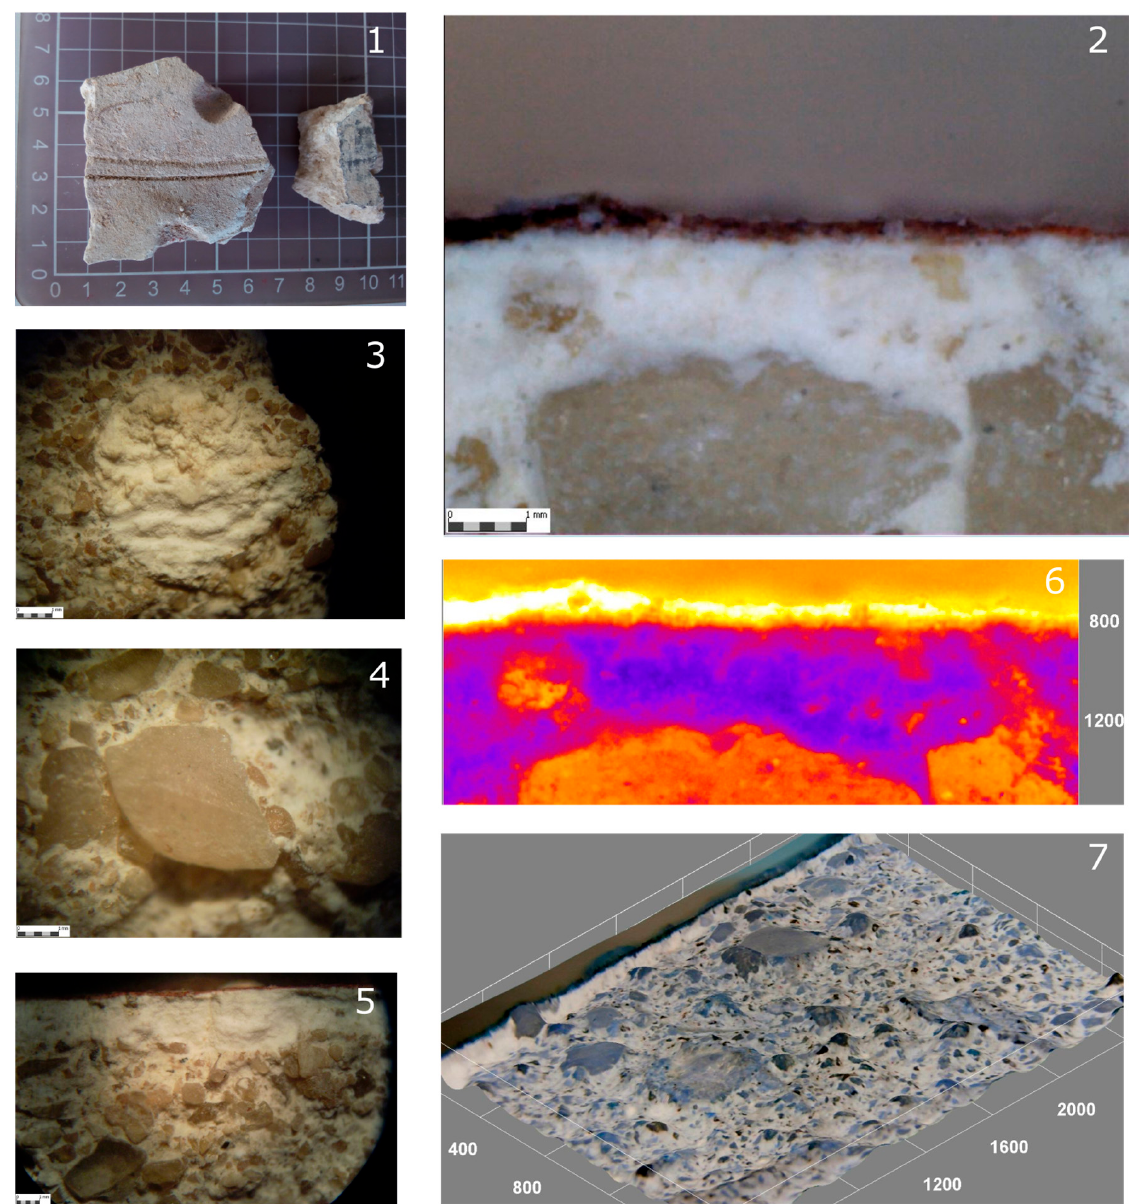
Figure 4. Macroscopic analysis of sample NO1 (1 mm scale): (1) Photo of sample before treatment, (2) cross-section without treatment (×50 mag.), (3) lumps of lime, (4) quartz grains, (5) cross section with reflected light, (6) thermal LUT analysis of cross section using ImageJ software showing the outside layer (yellowish), and (7) photogrammetry surface of sample using ImageJ software showing the irregular distribution and sizes of aggregates.